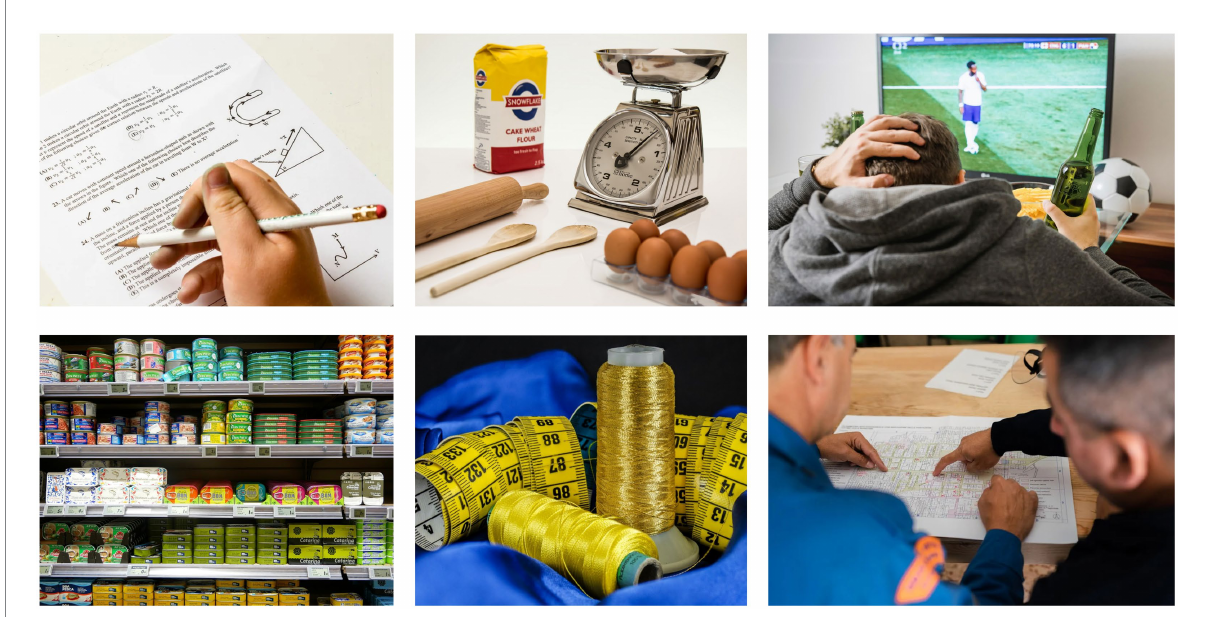
FIGURE 7 Given the situated nature of cognition, there is no “problem solving in general” because in real life there is no “problem in general” either: problems and solutions are always situation-specific. This is illustrated here with instances in which problem solving is paired to “mathematical reasoning”: rather than a discrete generic ability that merely gets implemented in some context or other, our use of quantity, numbers and their relations always involves local adaptations to situation-specific circumstances that shape the “problem” we are trying to address, for instance at school (top left), when baking (top center), when trying to assess your soccer team’s odds of overcoming an adverse aggregate score where home and away goals are weighted differently (top right), when shopping on a tight budget (bottom left), when sewing (bottom center), and at work as a civil engineer (bottom